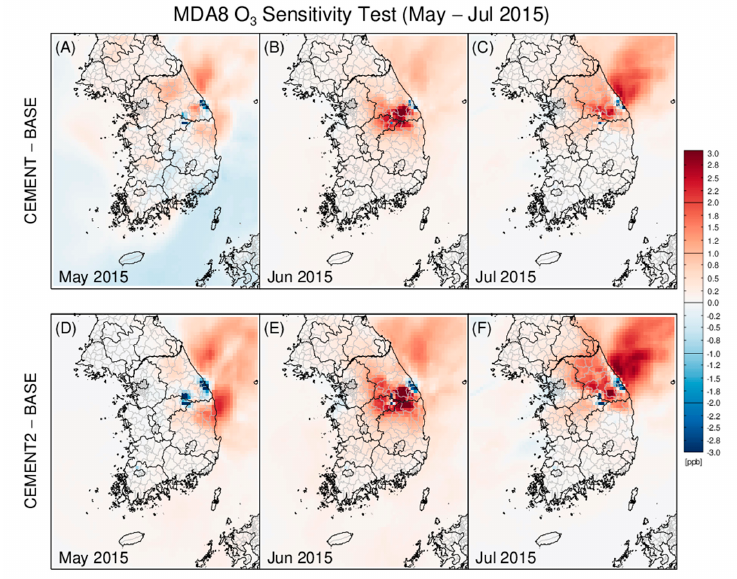
Figure 7. Impact of emissions from the cement industry on MDA8 O3 during May to July 2015. Simulated impacts are shown based on the current CAPSS 2013 emissions inventory ( A – C ) and satellite measurements ( D – F ).